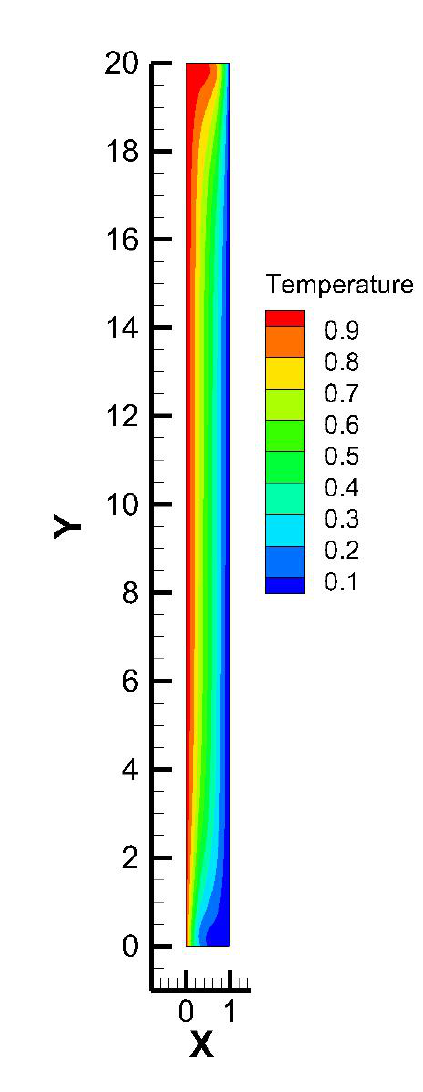
Fig. 4. The temperature field for Ra = 4850